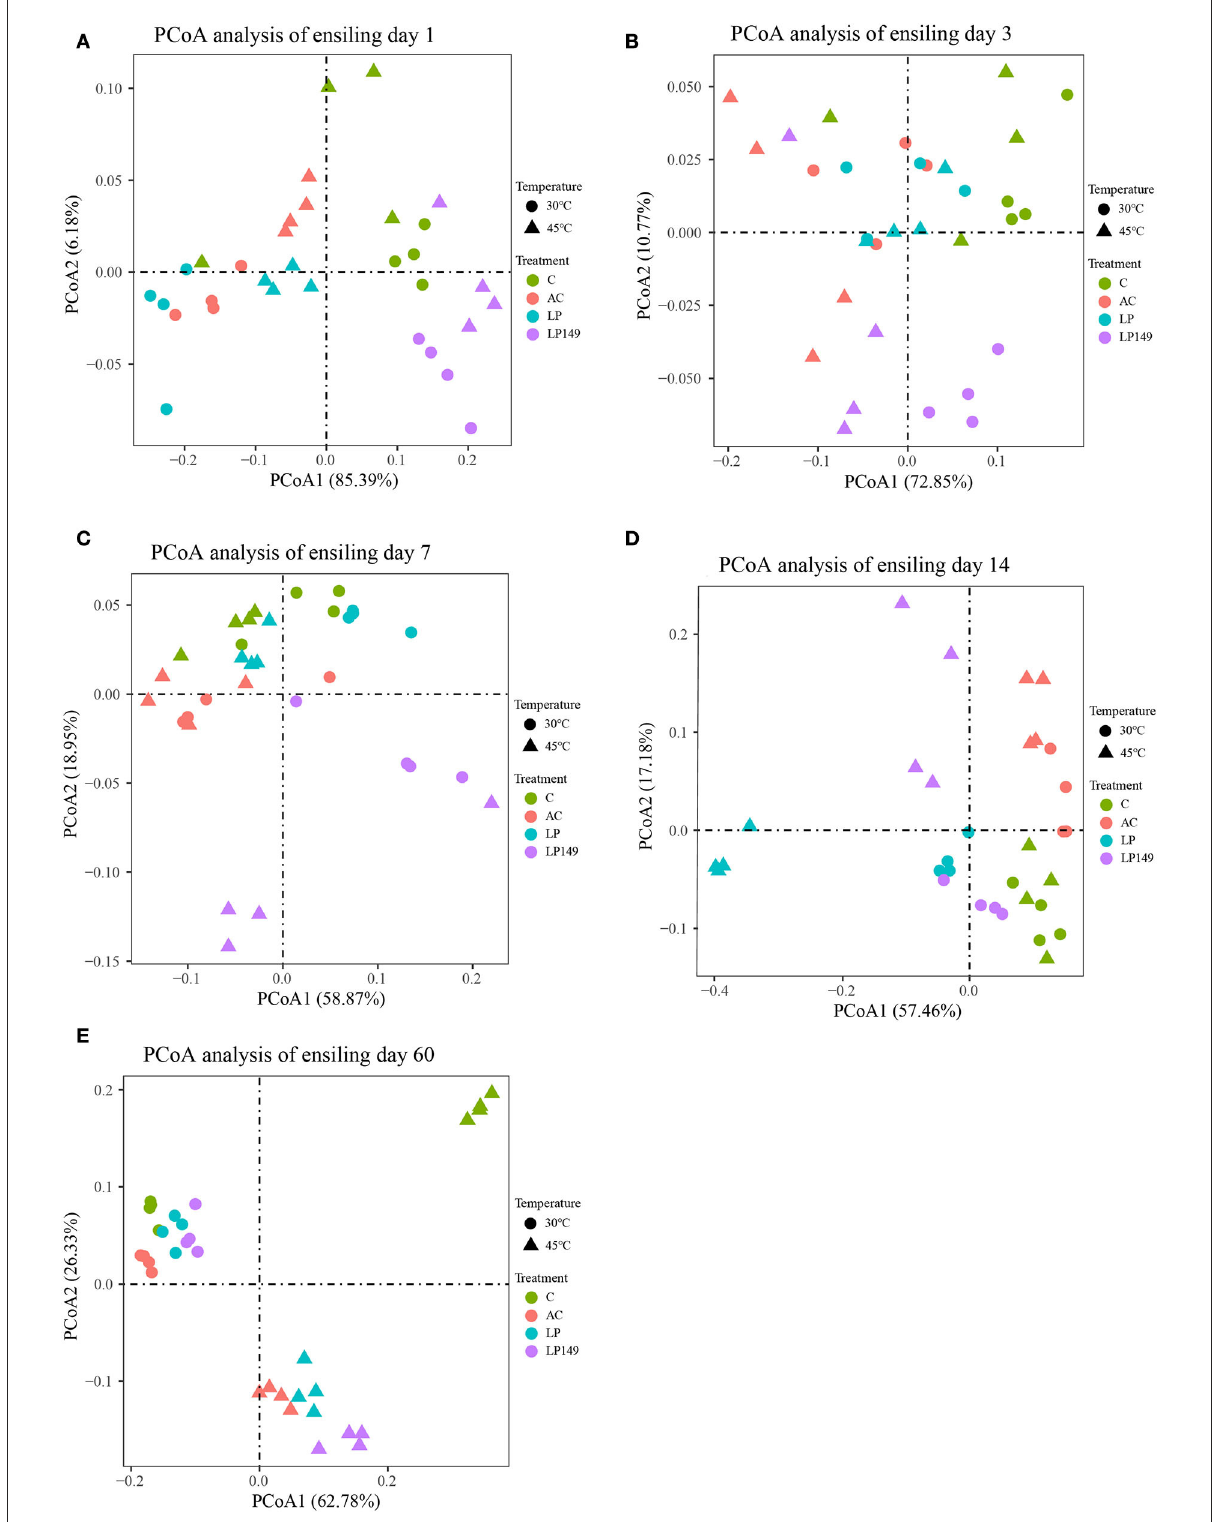
FIGURE3 Principal coordinates analysis (PCoA) of the bacterial community of hybrid elephant grass during ensiling. (A–E) indicates PCoA analysis at ensiling day 1, 3, 7, 14, and 60, respectively. C, control; AC, Acremonium cellulase; LP, commercial inoculant Lactobacillus plantarum ; LP149, Lactobacillus plantarum